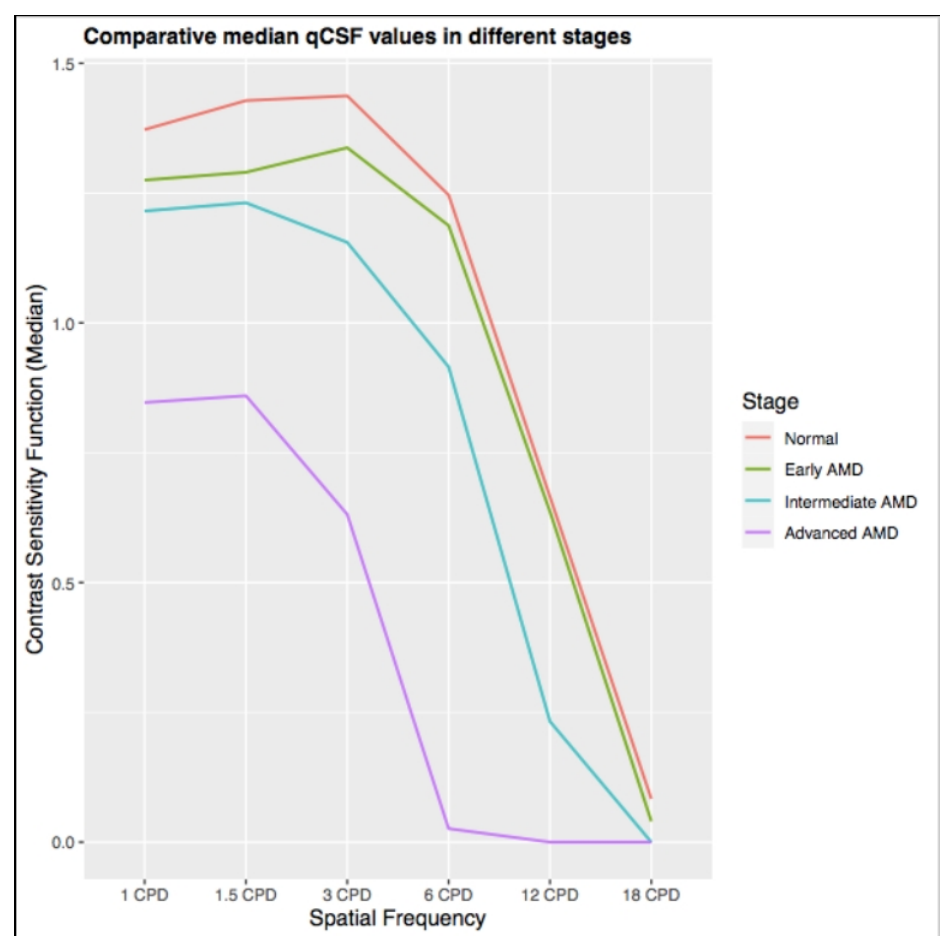
Figure 3. Contrast sensitivity function as measured by the qCSF in early, intermediate and advanced non-neovascular (dry) AMD compared to healthy controls. The qCSF seems to be able to differentiate between non-neovascular (dry) AMD stages (previously unpublished figure).